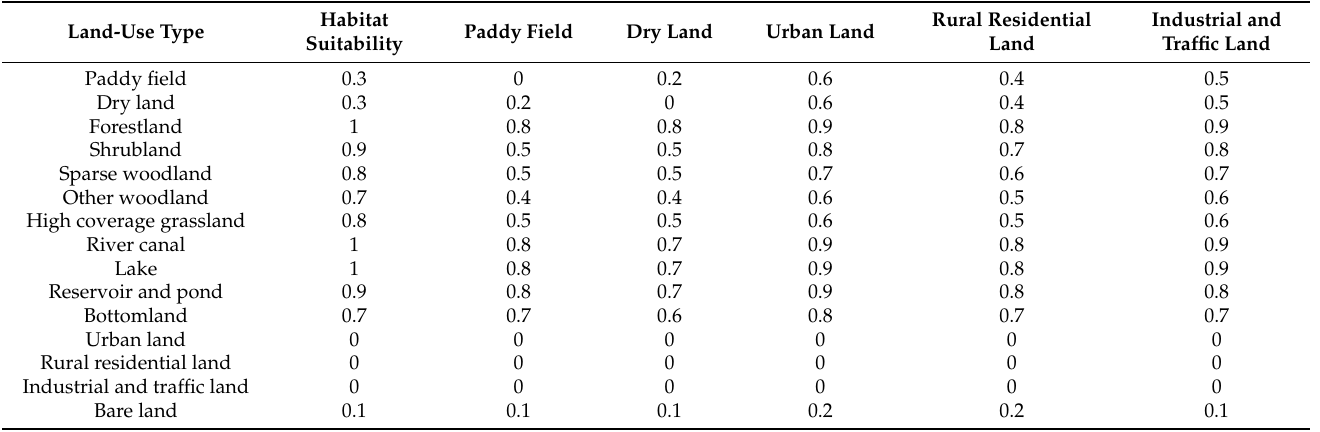
Table 3. The habitat suitability and sensitivity of land-use type to each threat